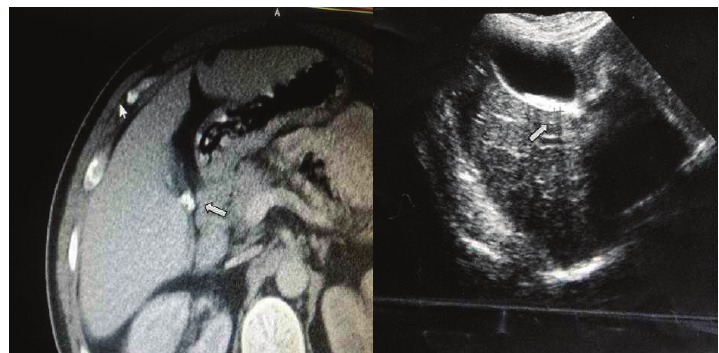
Figure 1: Parathyroid scintigraphy in patient with primary hyperparathyroidism: 99mTc sestamibi SPECT (white arrows).